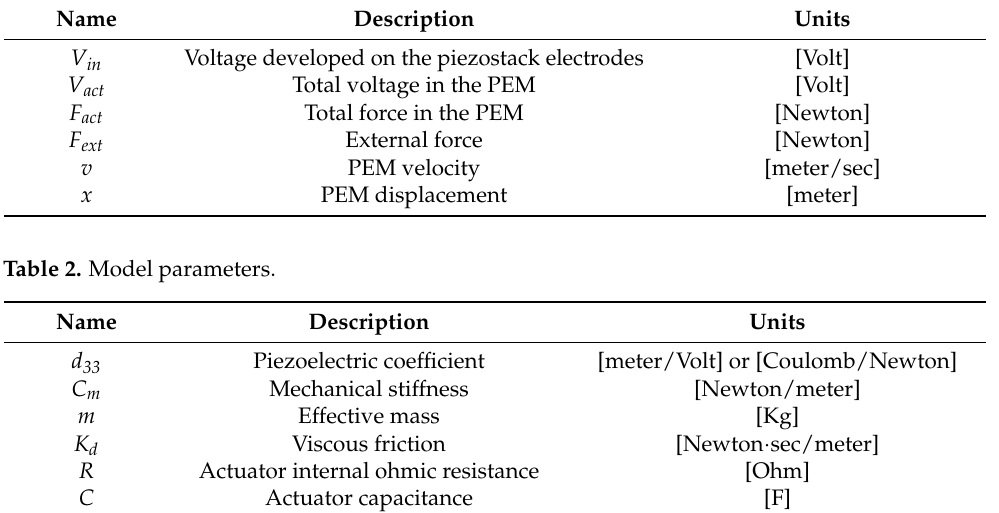
Figure 6. Classical hysteresis curve of PEMs [62]. Another method uses one measured curve and defines a mathematical process in order to evaluate any other possible curve [63]. In order to better facilitate the modeling of the hysteresis phenomenon, we developed a new and simpler algorithm, which deter- mines one normalized basic curve and calculates the numerical relation to any other pos- sible curve. We make this calculation by measuring the input signal and defining its di- rection as a function of time, without knowing its minimum and maximum values. In general, this algorithm considers the tendency of the voltage applied on the pie- zostack. Each of these curves is described by a set of two equations, one for the positive derivative and the other for the negative derivative. The algorithm is described in detail in a previous piece of work [24].